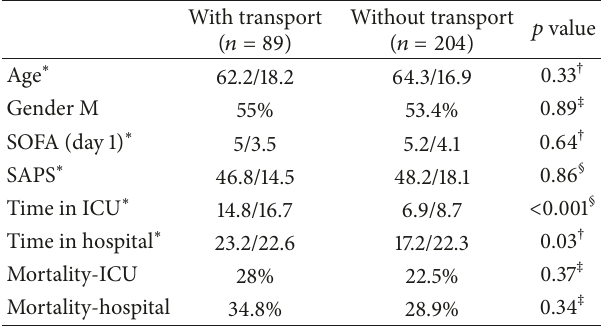
Table 2: Comparison of demographic data and prognostic scores of critically ill patients with and without intrahospital transport.